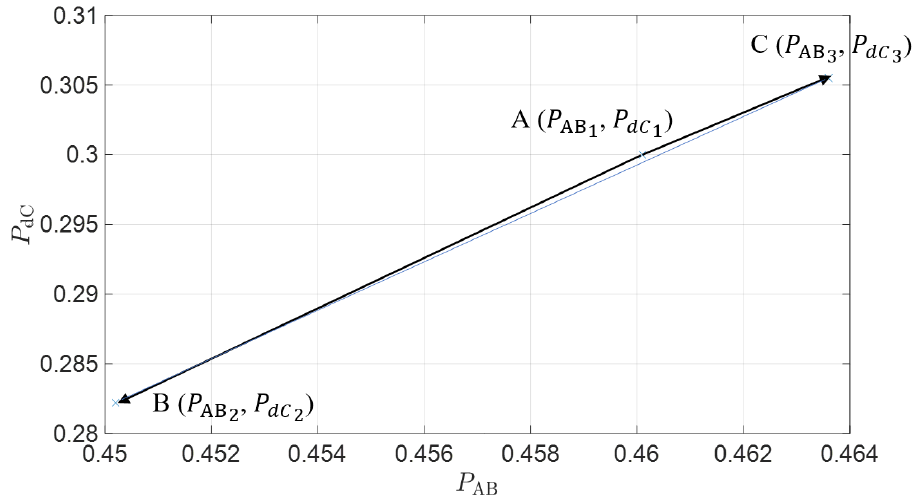
Figure 2. P AB − P dC diagram of N-KZFS11, N-SF66, and N-PK52A. Figure 2. P − P AB dC diagram of N-KZFS11, N-SF66, and